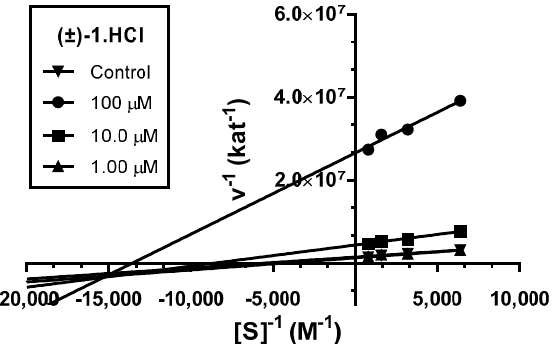
Figure 3. Steady-state inhibition of h AChE hydrolysis of substrate acetylthiocholine by novel huprine derivative ( ± )- 1 · HCl at different concentrations. Lineweaver − Burk plots of initial velocity at increasing substrate concentrations (0.156–1.250 mM) are presented. Lines were derived from a linear regression of the data points.